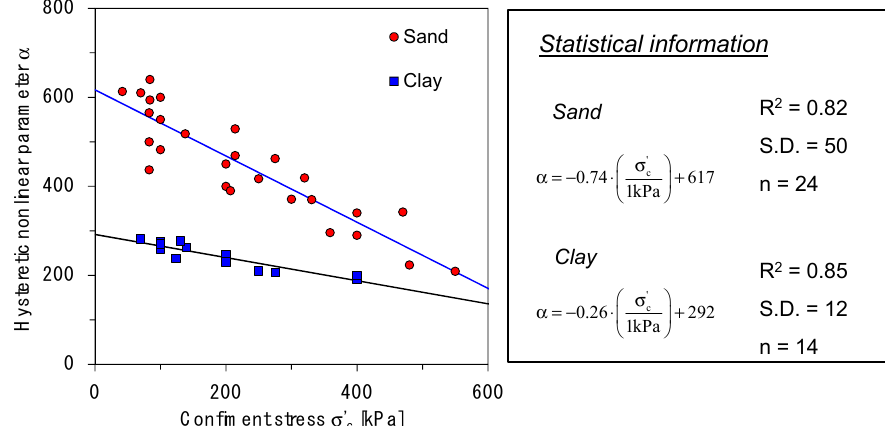
Figure 6. Correlation between hysteretic nonlinear parameter and confinement stress for sand and clay (S.D. stands for standard deviation).